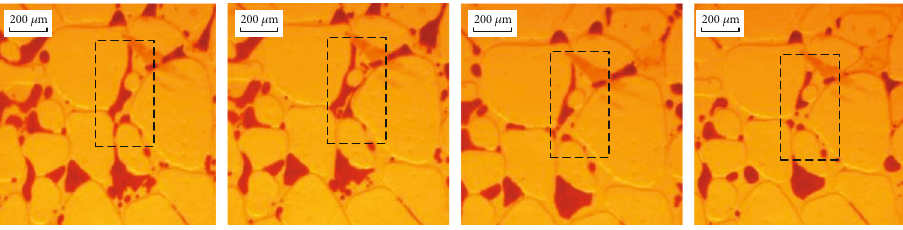
Figure 14: Schematic diagram of the displacement process of oil fi lm residual oil (oil in pores is indicated by the red